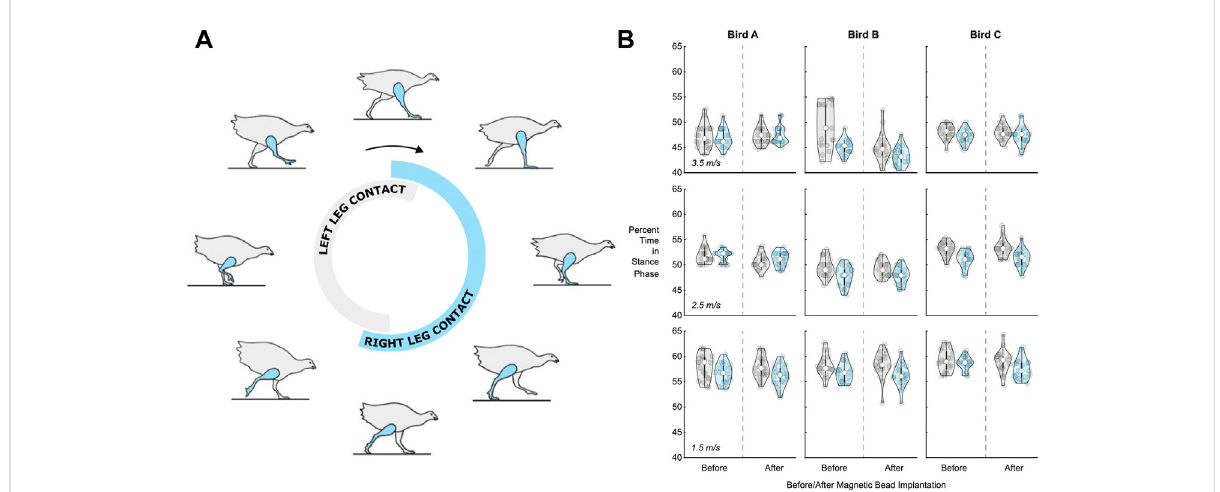
FIGURE 5 Percentage of stride time in stance phase before and after surgery. (A) Turkey gait cycle showing the portion of gait when the leg is in contact withtheground(thestancephase)duringrunning.Thecontacttimefortherightleg,whichreceivedtheimplants,isshowninblue,whilethecontact time for the left leg is shown in gray, for reference. (B) Violin plots for left leg (gray, for reference) and right leg (blue) percentage of stride time in stance phase ( n = 20 strides) for each bird (A, B, and C) at 1.5 m/s (bottom), 2.5 m/s (middle), and 3.5 m/s (top). See Supplementary Table S1 for the full dataset in table form.